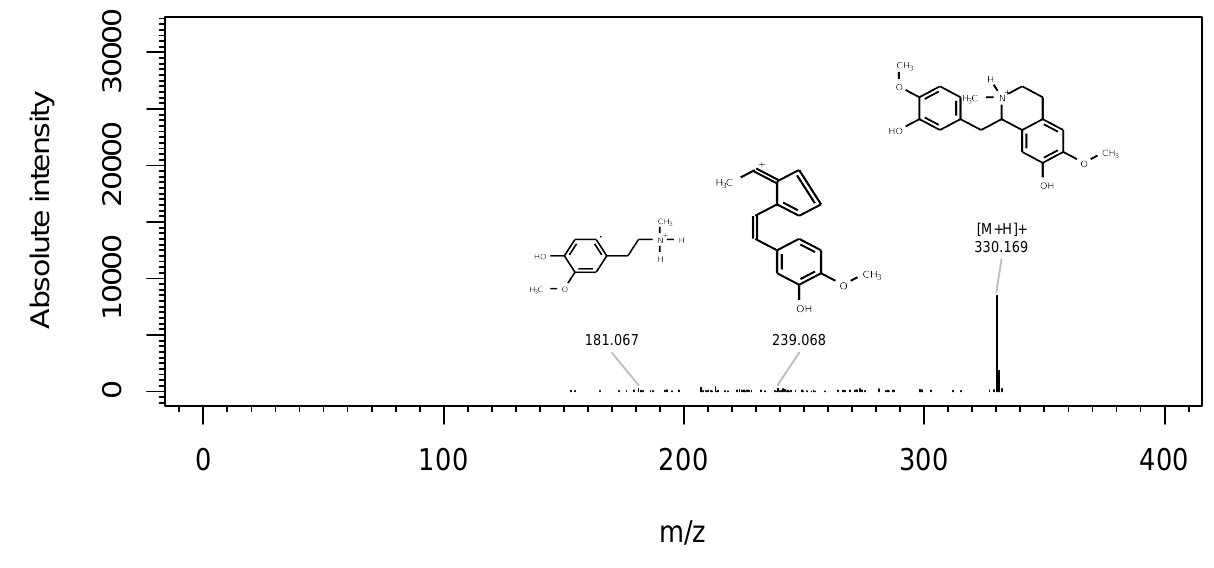
Figure A5. Challenge 5: annotated merged MS/MS spectra of reticuline (ESI, positive mode).